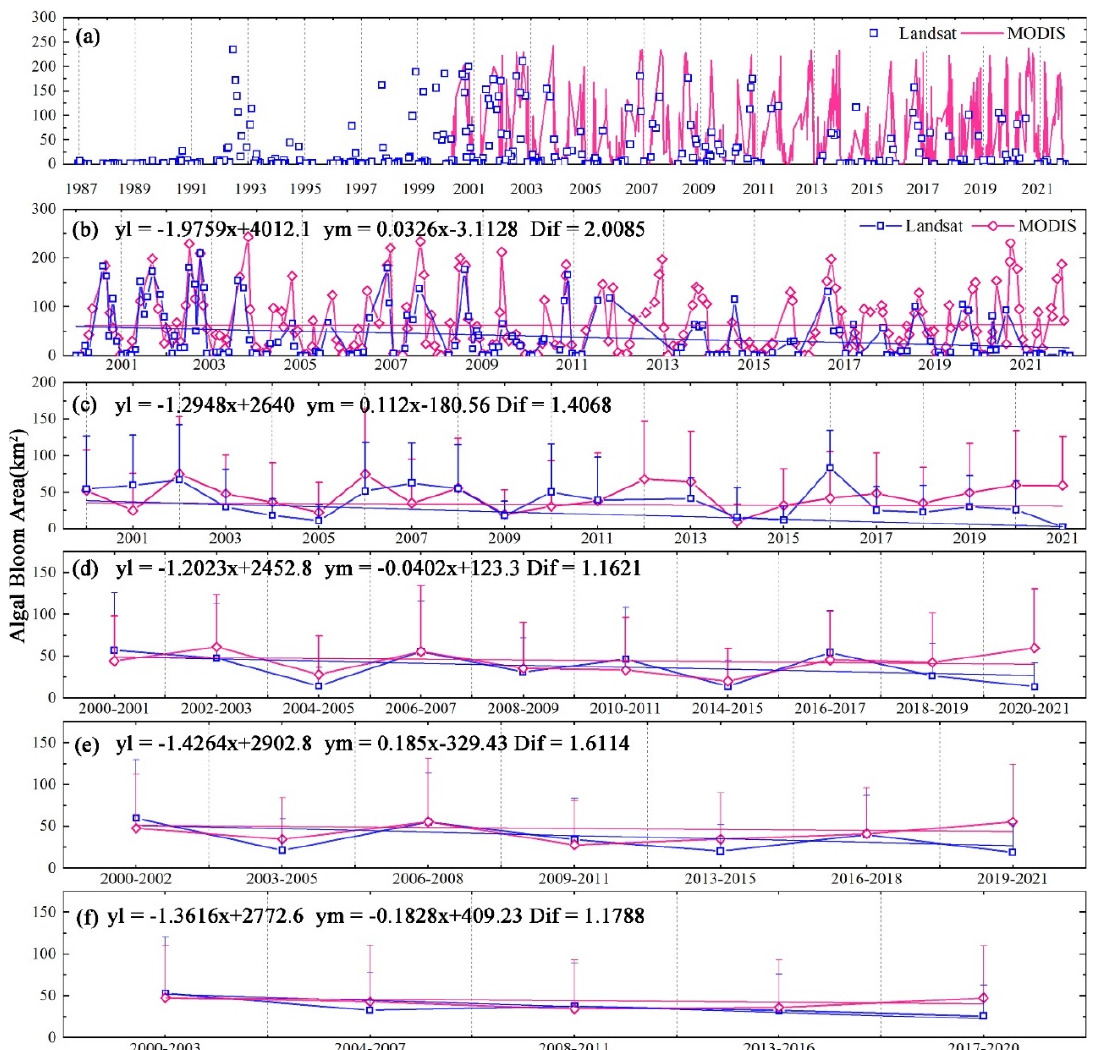
Figure 3. Time series of different time scales of the average algal bloom area in Lake Dianchi between the Landsat and MODIS/Terra results (during 2000–2021). The time intervals of ( a – f ) are 1 day, 1 month, 1 year, 2 years, 3 years, and 4 years, respectively. “ym” represents the fitting equation of the time series obtained from MODIS/Terra images at the current time scale. “yl” represents the fitting equation of the time series obtained from Landsat images at the current time scale. “x” represents the independent variable of the fitting equation of the time series at the current time scale. “Dif” represents the slope difference between the MODIS/Terra time series and the Landsat time series. The lower the Dif, the greater the similarity of the trends between the time